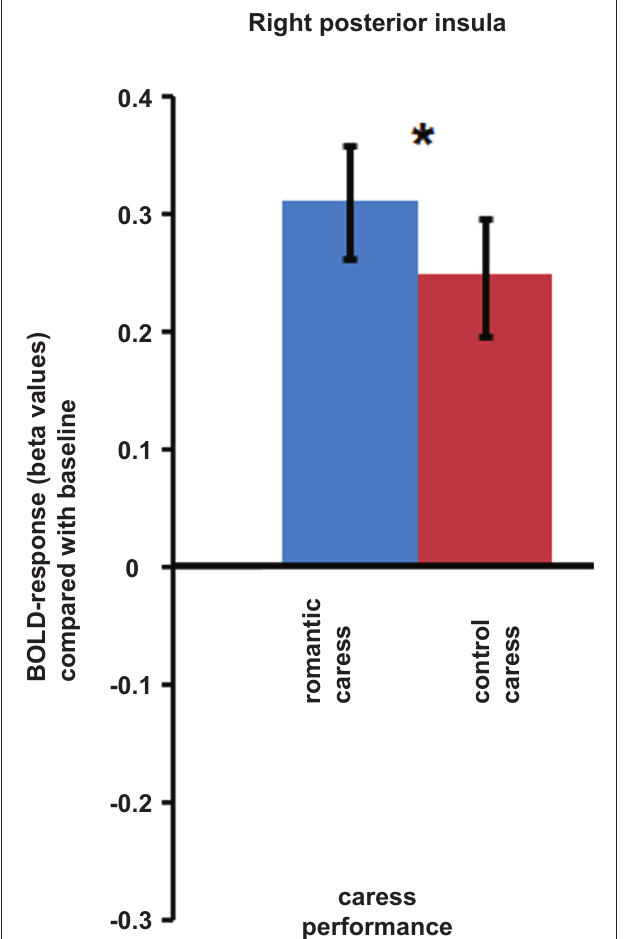
were found in bilateral primary and secondary somatosensory cortex (S2), bilateral posterior insula, bilateral superior parietal cortex (SPC), bilateral inferior parietal lobule, bilateral mid cin- gulate cortex (MCC), bilateral precentral gyrus (PreCG), right inferior frontal gyrus, right cerebellum ( p < 0.01 corrected, t > 3.61, k > 8). The control caress intention condition,